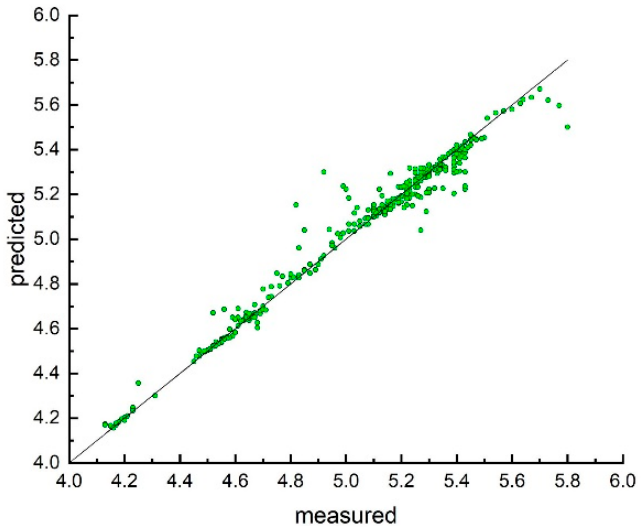
Figure 4. Distribution of the experimental and predicted values of the extinction coefficient calculated by consensus model developed with n = 335 compounds experimentally measured in this work.